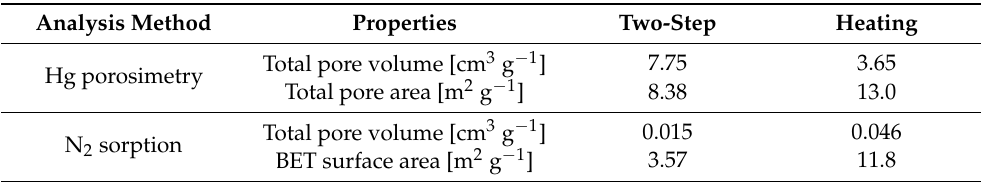
Table 3. Summary of the porosity characteristics of the two eVMTs probed by Hg porosimetry and N 2 sorption.